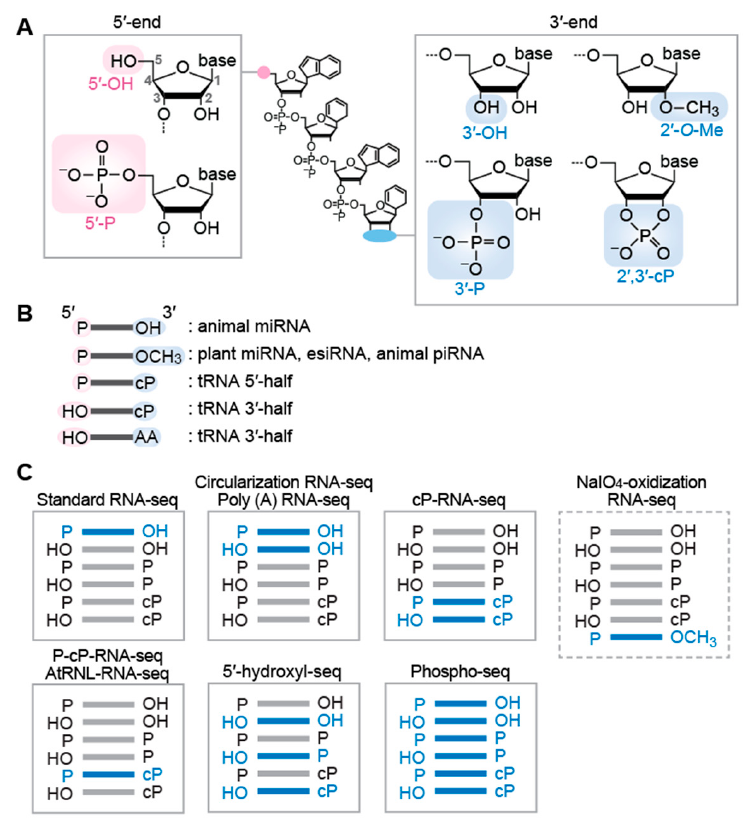
Figure 1. Terminal formations of sncRNAs and their compatible sequencings: ( A ) Chemical structures of RNA termini. ( B ) Terminal formations of sncRNAs. ( C ) Targeted sncRNAs (shown in blue) in each RNA-seq methods.